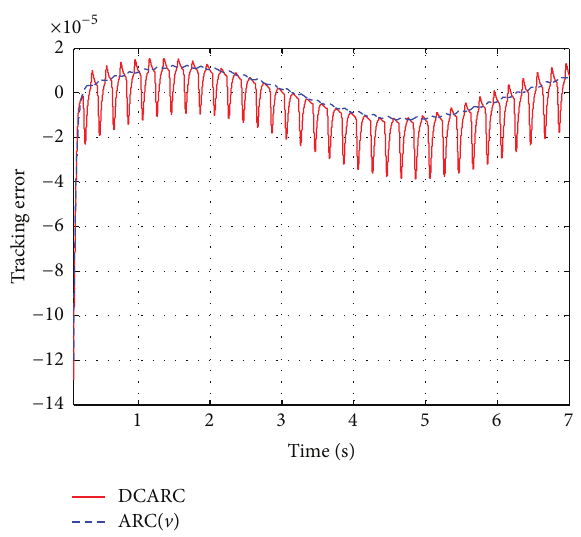
Figure 3: ARCs’ tracking errors in the presence of parametric uncertainty and uncertain nonlinearities.